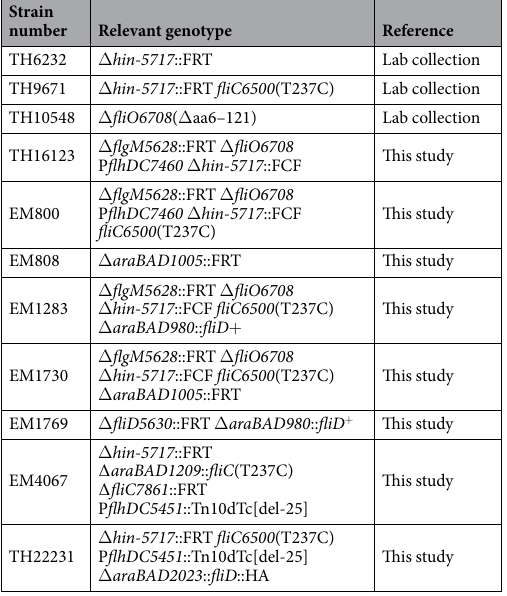
Table 2. Salmonella enterica serovar Typhimurium LT2 strains used in this